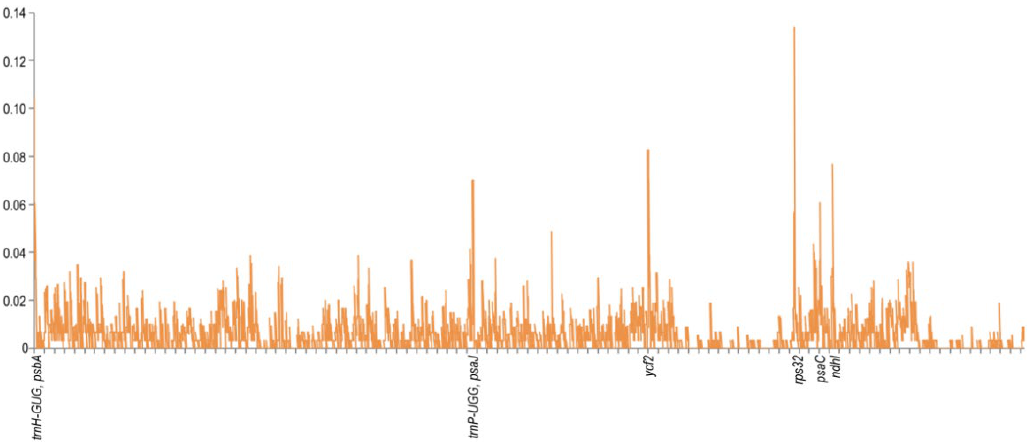
Figure 5. Comparison of the nucleotide variability (Pi) values among the seven species cp genomes. The Y-axis shows the Pi values; the X-axis shows the genes with high Pi values .